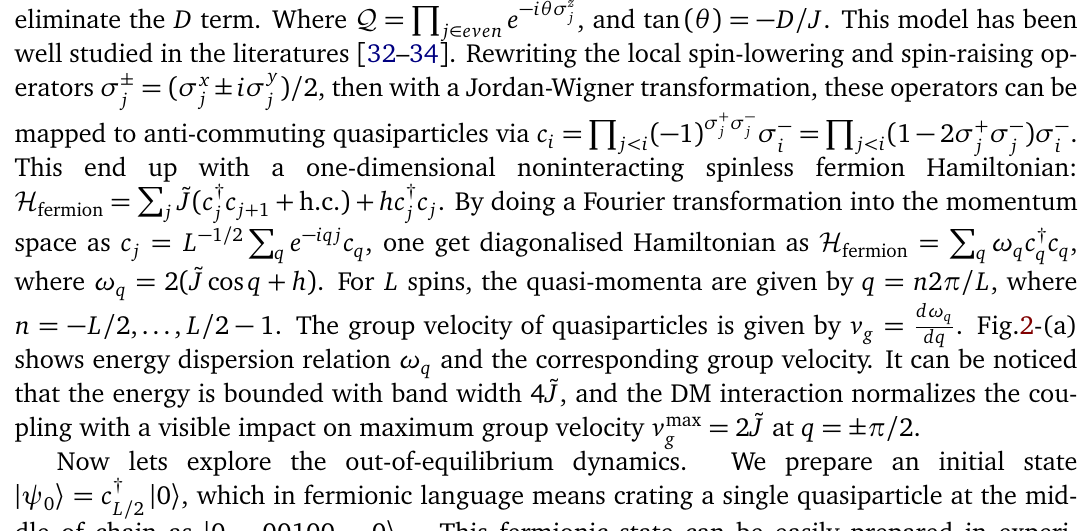
Figure 2: (colour online) (a) Energy dispersion (left panel) relations for Hamiltonian in Eq.(4) for D = 0.0 and D = 1.0. The corresponding group velocity v shown in the right panel. (b) single site occupation 〈 ψ tion at L / 2 spreads light-cone-like, bonded by the maximal group velocity v shown with dashed